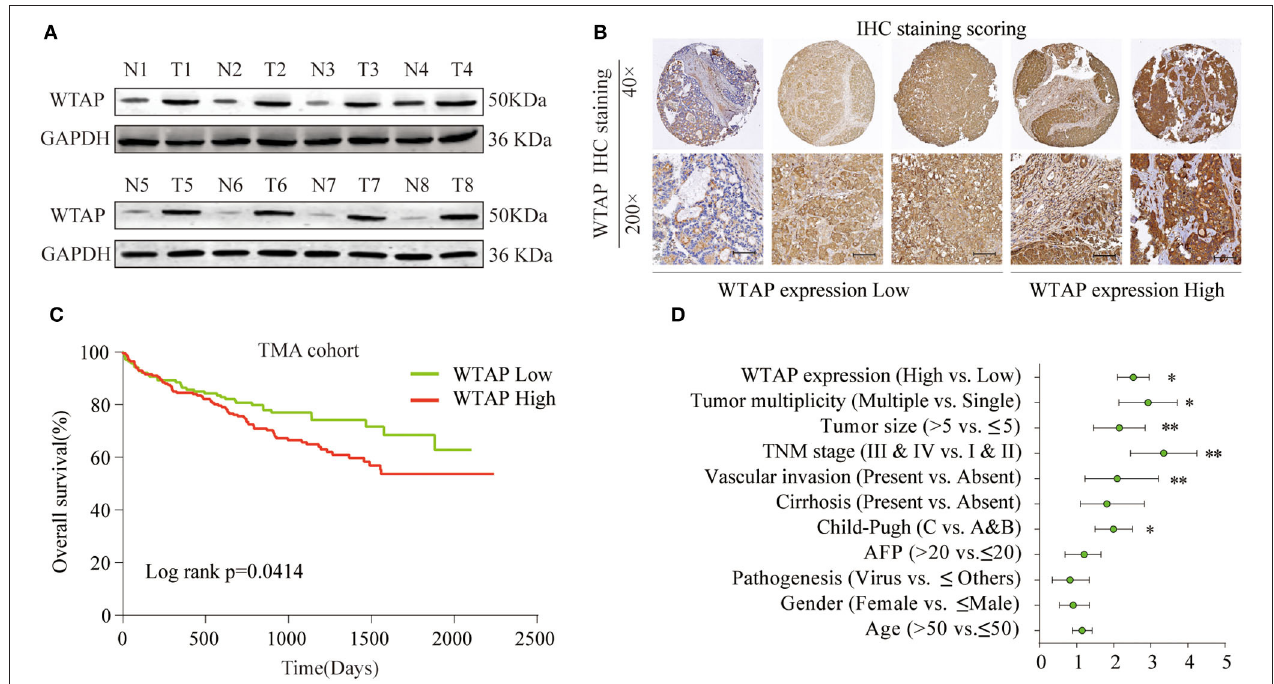
FIGURE 1 | High Wilms’ tumor 1-associating protein (WTAP) expression is significantly correlated with a poor prognosis in patients with hepatocellular carcinoma (HCC). (A) WTAP expression in eight-paired HCC tissues (T) and the adjacent non-cancer tissues (N) was analyzed by using a western blot. (B) Representative immunohistochemical (IHC) staining of WTAP in HCC tissues and the relative scores of the WTAP expression based on the WTAP staining intensity. (C) The Kaplan–Meier analysis was used to analyze a correlation between the WTAP expression and the overall survival (OS) of patients with HCC. (D) Univariate analysis of the association between the WTAP expression and different clinicopathological features. * p < 0.05, ** p < 0.01 based on the non-parametric test.